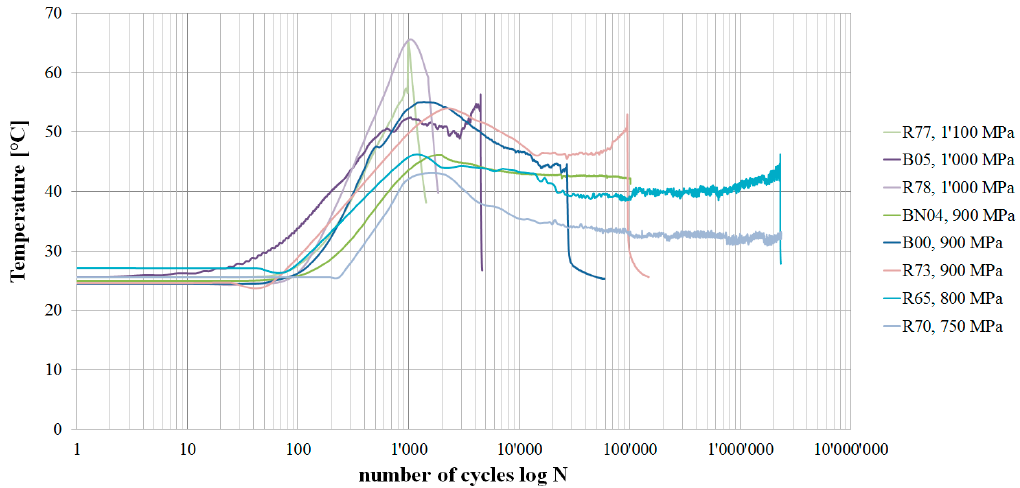
Figure 8. Temperature curves of fretting fatigue tested CFRP straps. Curves shown for straps tested at an upper load level between 750 and 1,100 MPa.